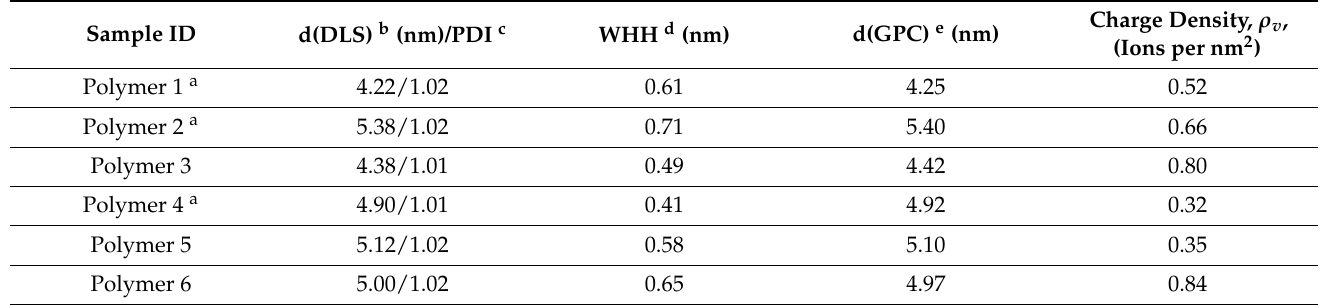
Table 3. Measured and calculated particle size (diameter), polydispersity index of particle size (PS-PDI), width at half height (WHH) and charge density of the CUPs.